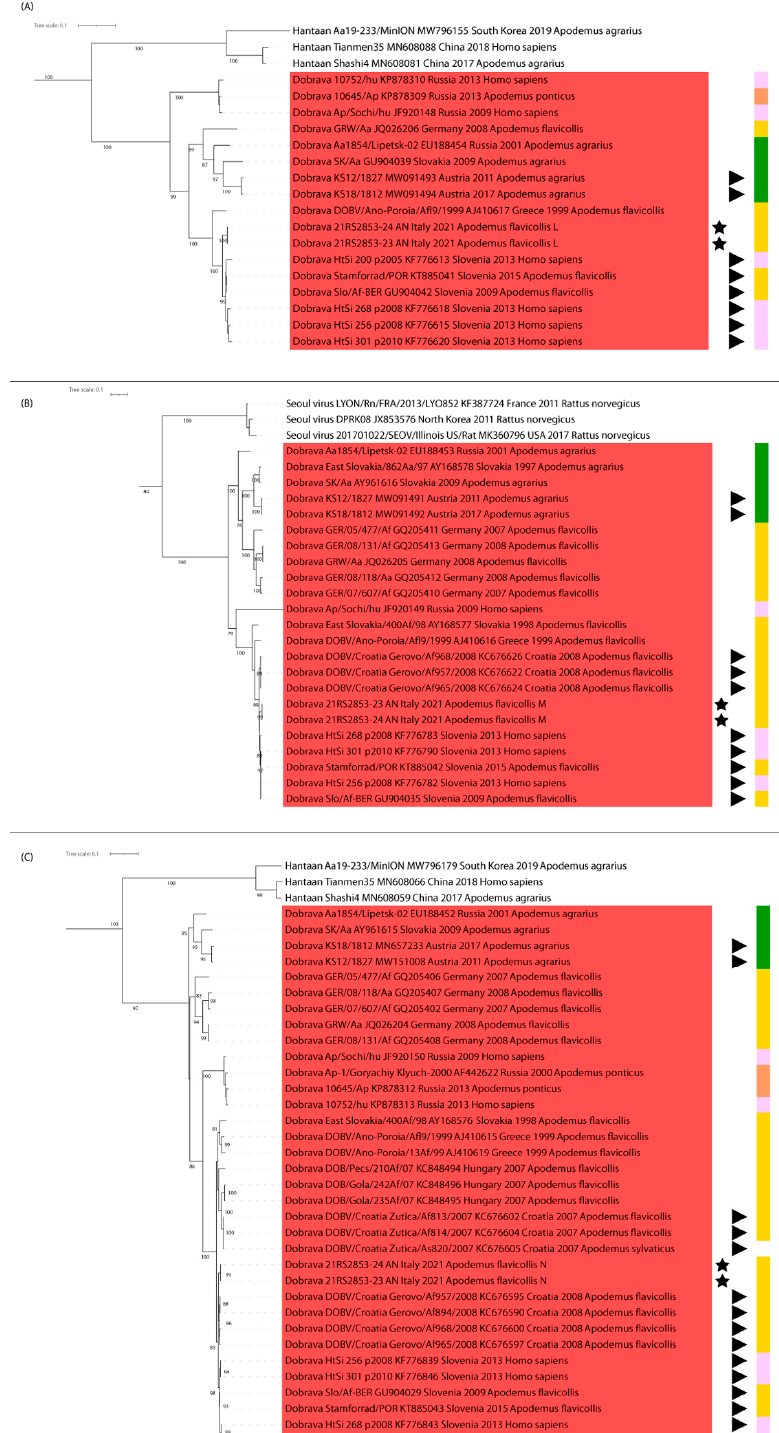
Figure 1. ML phylogenetic trees of the whole sequences for segments L ( A ), M ( B ) and S ( C ). The red box shows the viruses belonging to the specie Dobrava-Belgrade orthohantavirus . Original